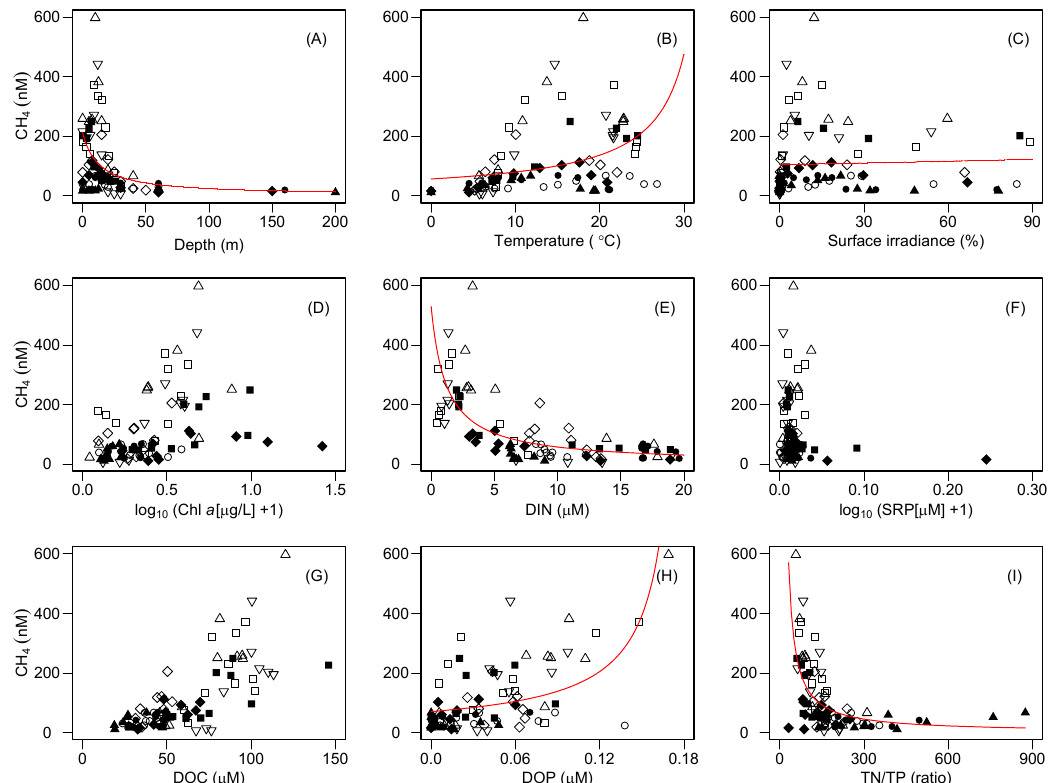
Figure 2. Relationships between environmental variables and dissolved CH 4 concentrations in the study lakes. Univariate regression lines are shown for the explanatory variables that were retained in the best generalized linear models (GLMs) with a gamma distribution of the response variable. □: Lake Ashinoko, ○ : Lake Motosu, △ : Lake Saiko, ◇ : Lake Aoki, ▽ : Lake Nojiri, ◆ : Lake Chuzenji, ■ : Lake Hibara, ●: Lake Toya, ▲ : Lake Shikotsu.